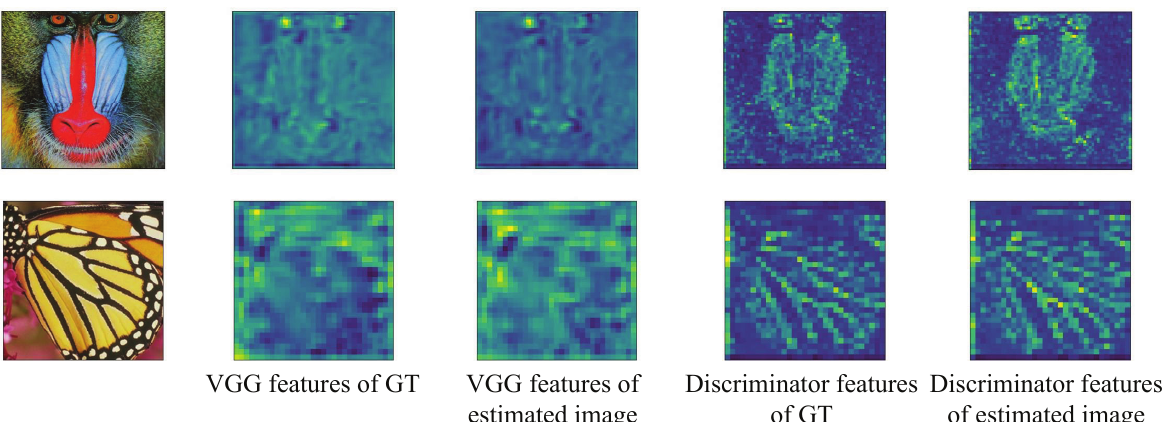
Figure 3. Comparison of VGG features and discriminator features on the estimated image and GT image. The estimated image is generated by